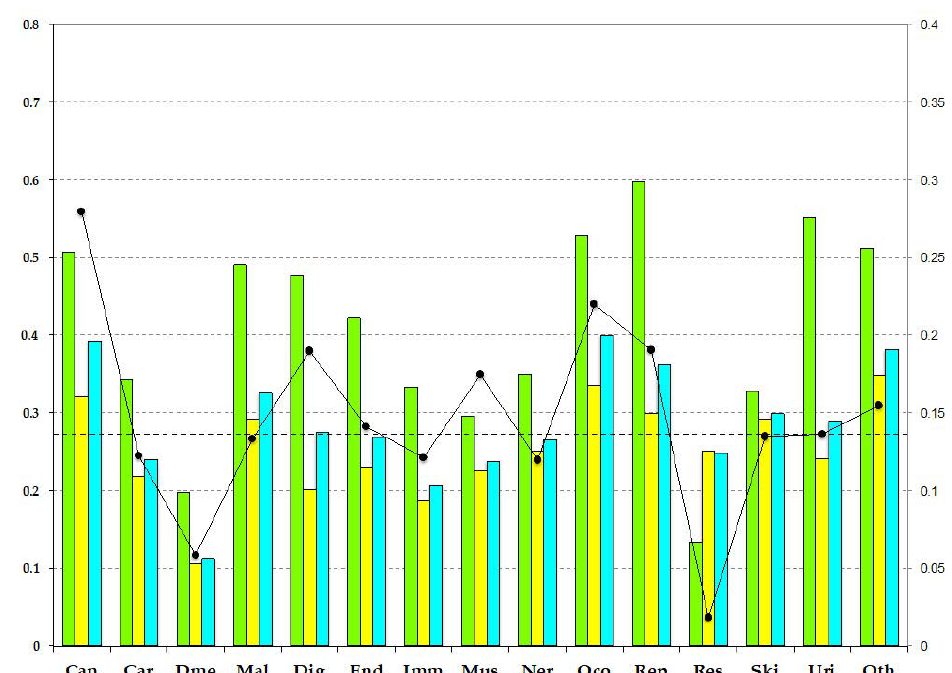
Figure 2. The IDR ratios by disease category. The green, yellow, and blue bars represent the IDR fractions of the pProS-containing proteins, the non-pProS proteins, and the total proteins in each of the disease categories, respectively. The measure on the left axis represents the IDR fractions. The black line with dots represents the protein coverage found in Table 2. The measure on the right axis represents the protein coverage. The dashed line represents the IDR ratio of the human proteome. Can: Cancers;